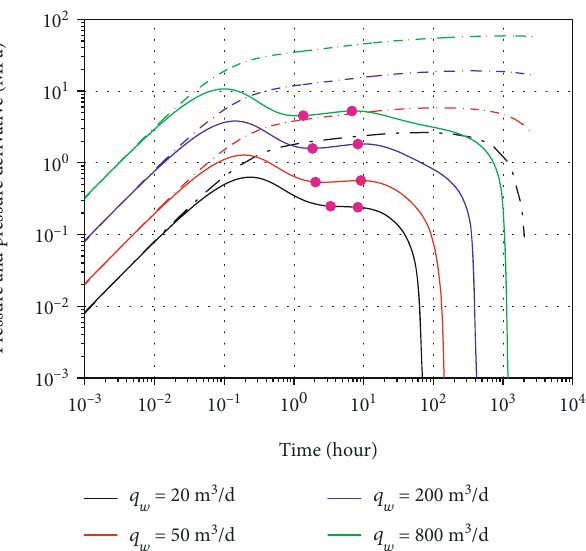
1 12: E ff ect of injection rate on pressure transient response. q is the injection rate of testing well before shut-in.